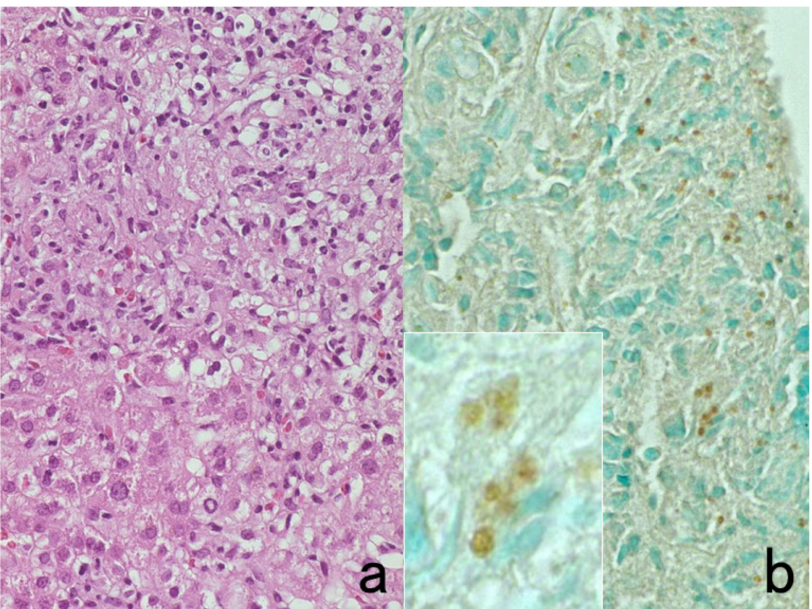
Figure 62. Immunostaining with the patient’s serum (I). Liver biopsy of visceral leishmaniasis (kala azar). ( a ): H&E and ( b ): 1:500 dilution of the patient’s own serum (inset: high-power view). Non-caseous epithelioid granulomas are dispersed in the liver parenchyma. Antibodies in the patients’ own serum identify red cell-sized positive signals in the cytoplasm of epithelioid cells and Kupffer cells. Although the specificity of the patient’s serum is totally unknown in this case, it significantly contributed to suggest the causative pathogens to be protozoa. The nuclei in panel ( b ) are counterstained with methyl green.